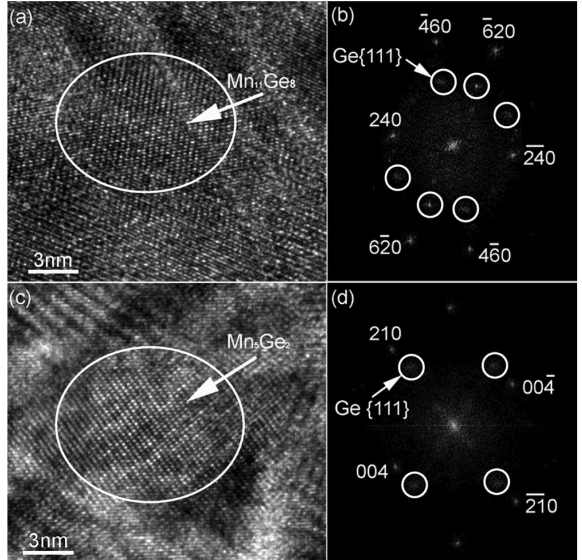
Figure 4 . (a) HR-TEM image showing a Ge (b) The FFT pattern of (a). (c) Typical HR-TEM image of a Ge sample. (d) The FFT pattern of (c). (Reprinted with permission from Ref. [33]. Copyright 2008, American Institute of